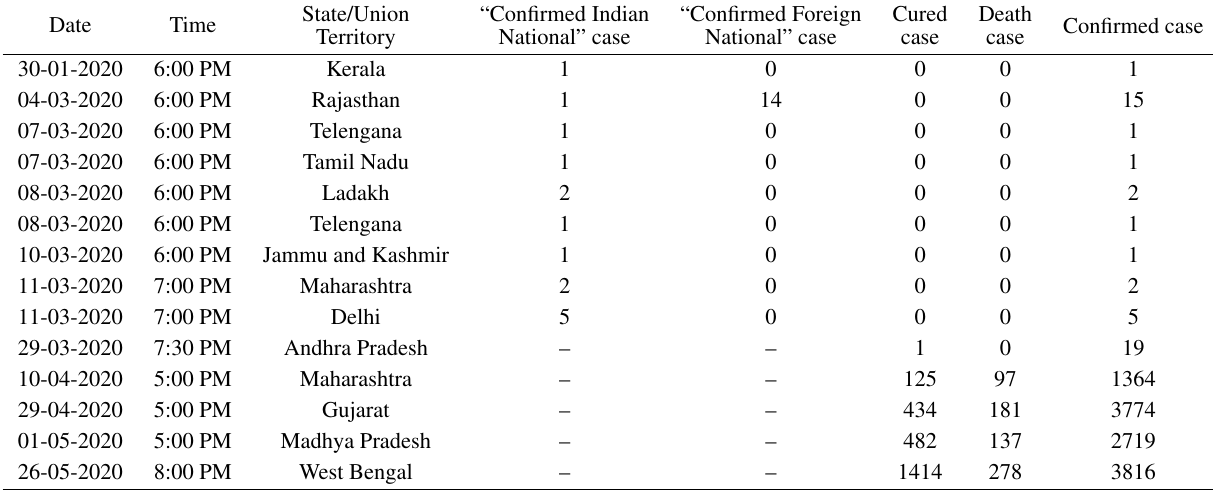
Table 2 Dataset on SARS-CoV-2 in India.